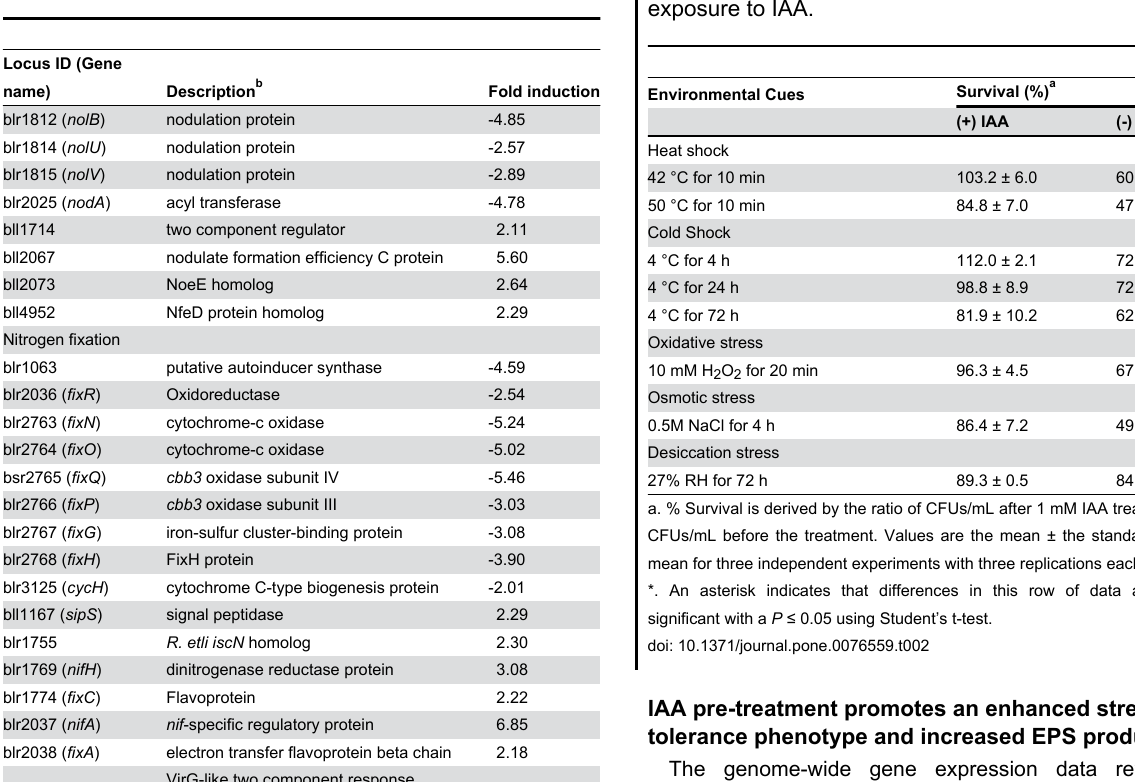
(blr2768), which are members of the fixGHIS operon were also repressed 3.08 and 3.90 fold, respectively (Table 1).